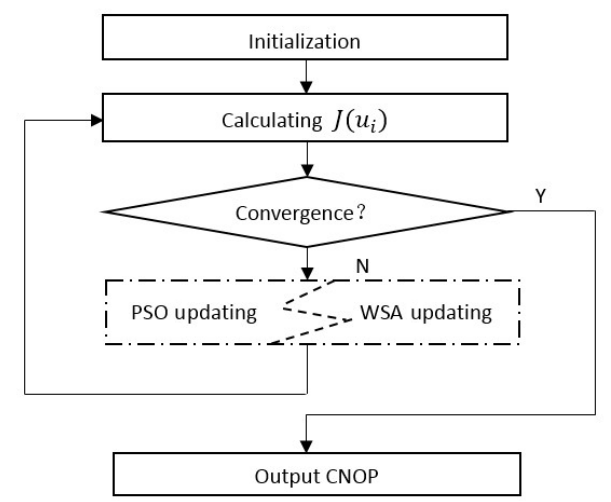
Figure 1. The framework of the ACPW